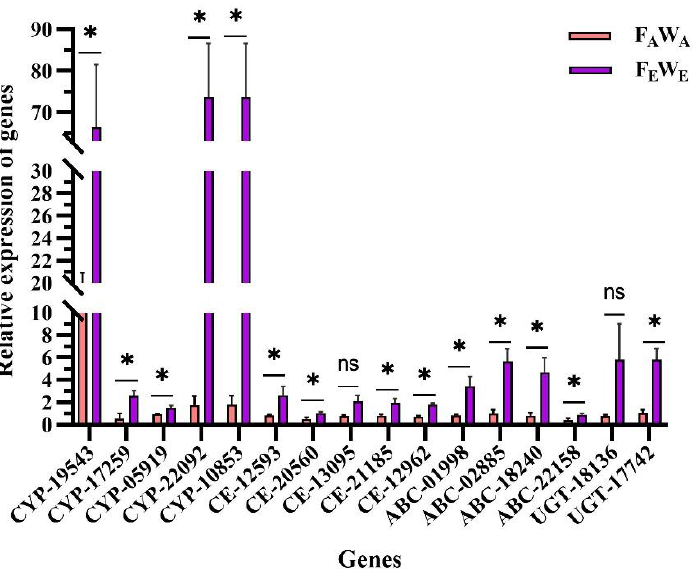
Figure 6. Quantitative real-time PCR (qRT-PCR) data of selected genes. Sixteen upregulated DEGs were selected for PCR analysis. RPL10-insects and RPL13-JIA were used as reference genes for qRT-PCR normalisation. The mRNA expression levels of the selected genes were calculated using the 2 − △△ CT method. Note: Asterisks denote significant difference between ambient and elevated CO 2 by the independent-sample t-test at p < 0.05, ns indicates insignificant.